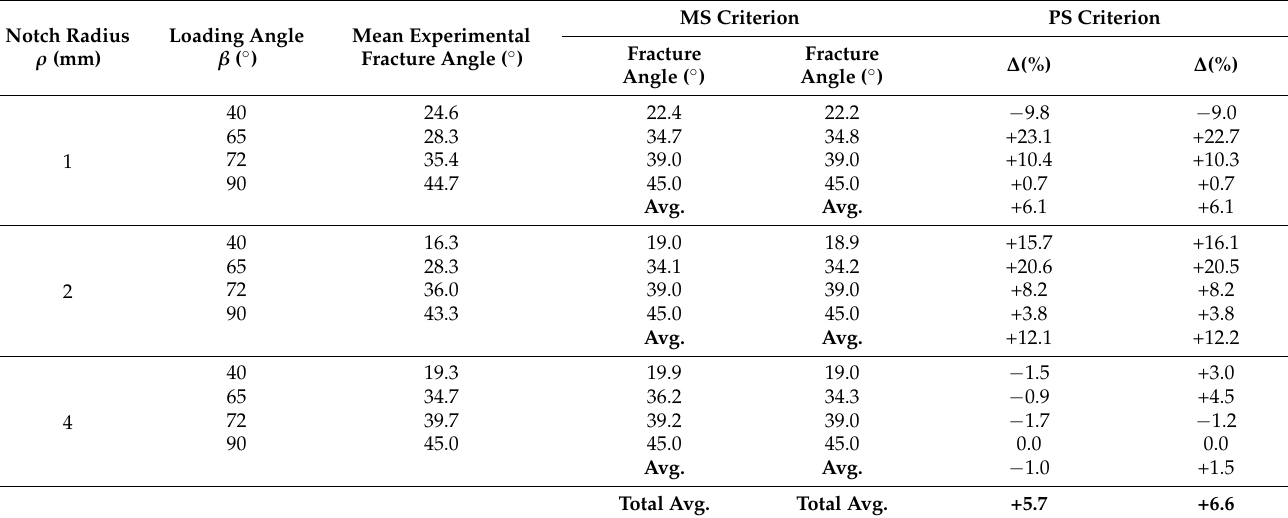
Table 4. Theoretical and experimental values of the out-of-plane fracture angle for the U-notched spruce wood samples together with the percent